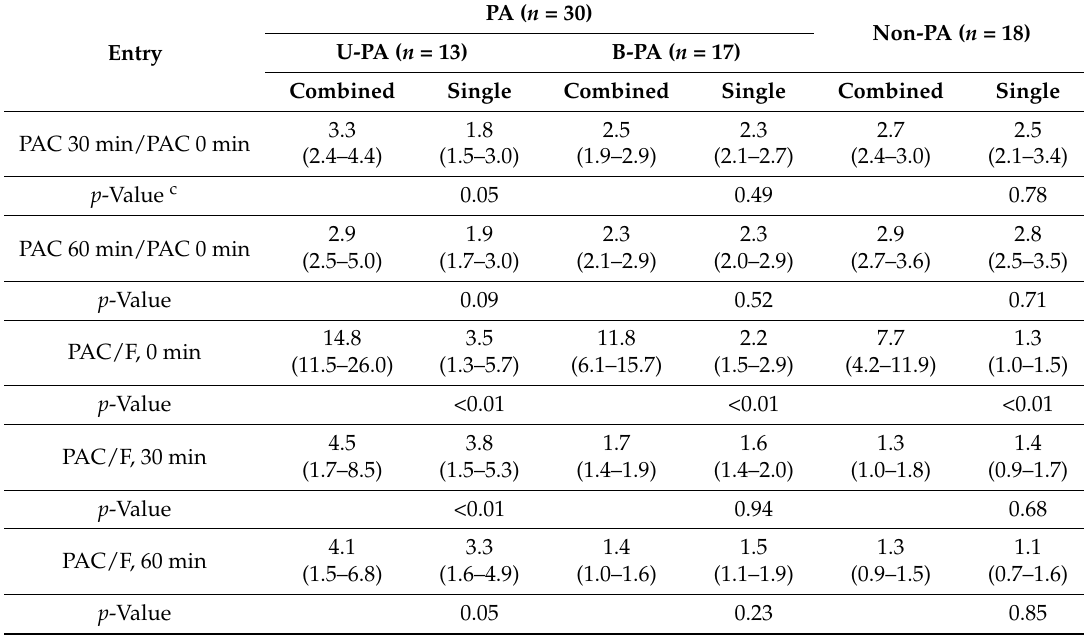
Table A1. Comparison of the increase ratio of PAC and the PAC/F ratio after ACTH stimulation between combined and single tests a,b